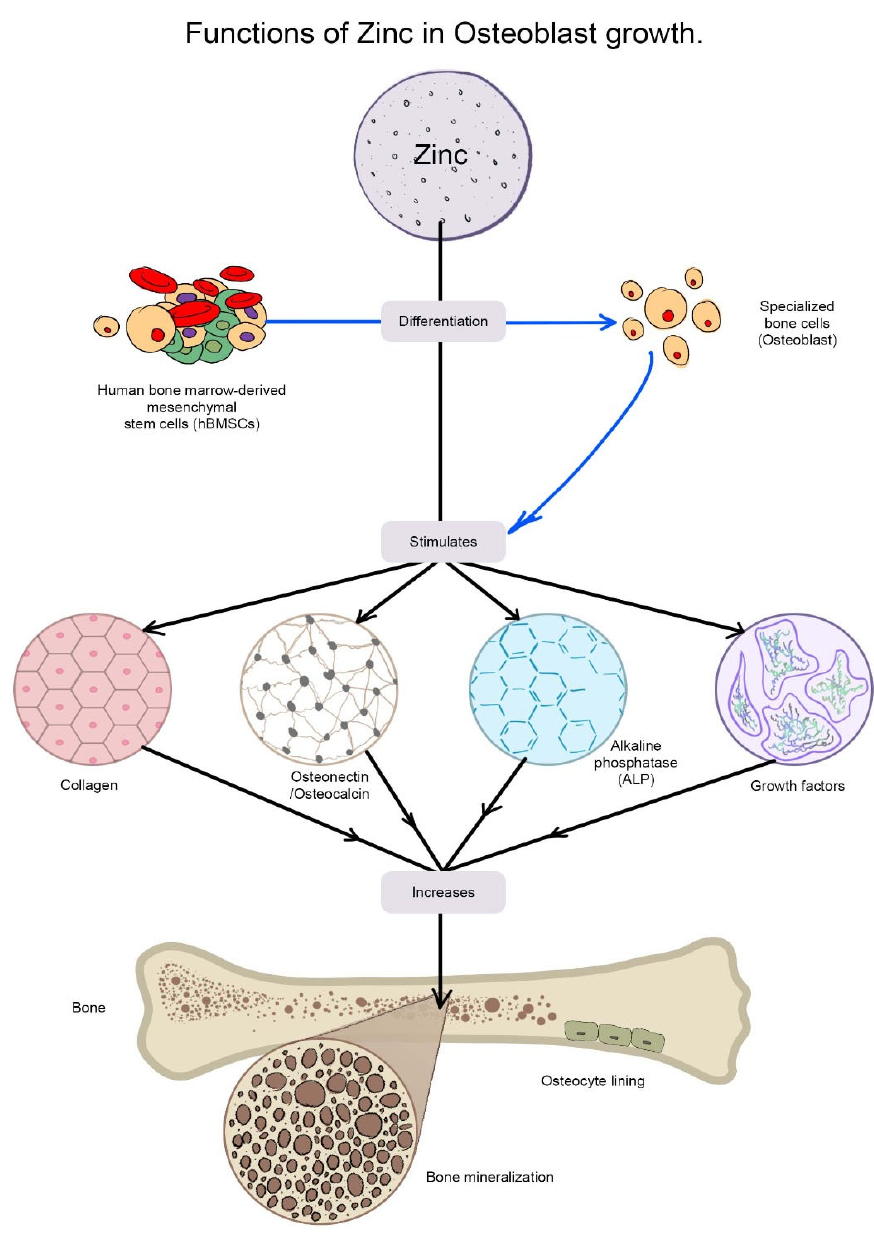
Figure 6. The diagram shows the functions of Zn in stimulating osteoblastic bone formation and mineralization. Zinc stimulates gene expression of various proteins including type I collagen, alkaline phosphatase, and osteocalcin in the cells. Zn is also known to increase the production of growth factors such as IGF-I and TGF- β 1 in osteoblastic cells.